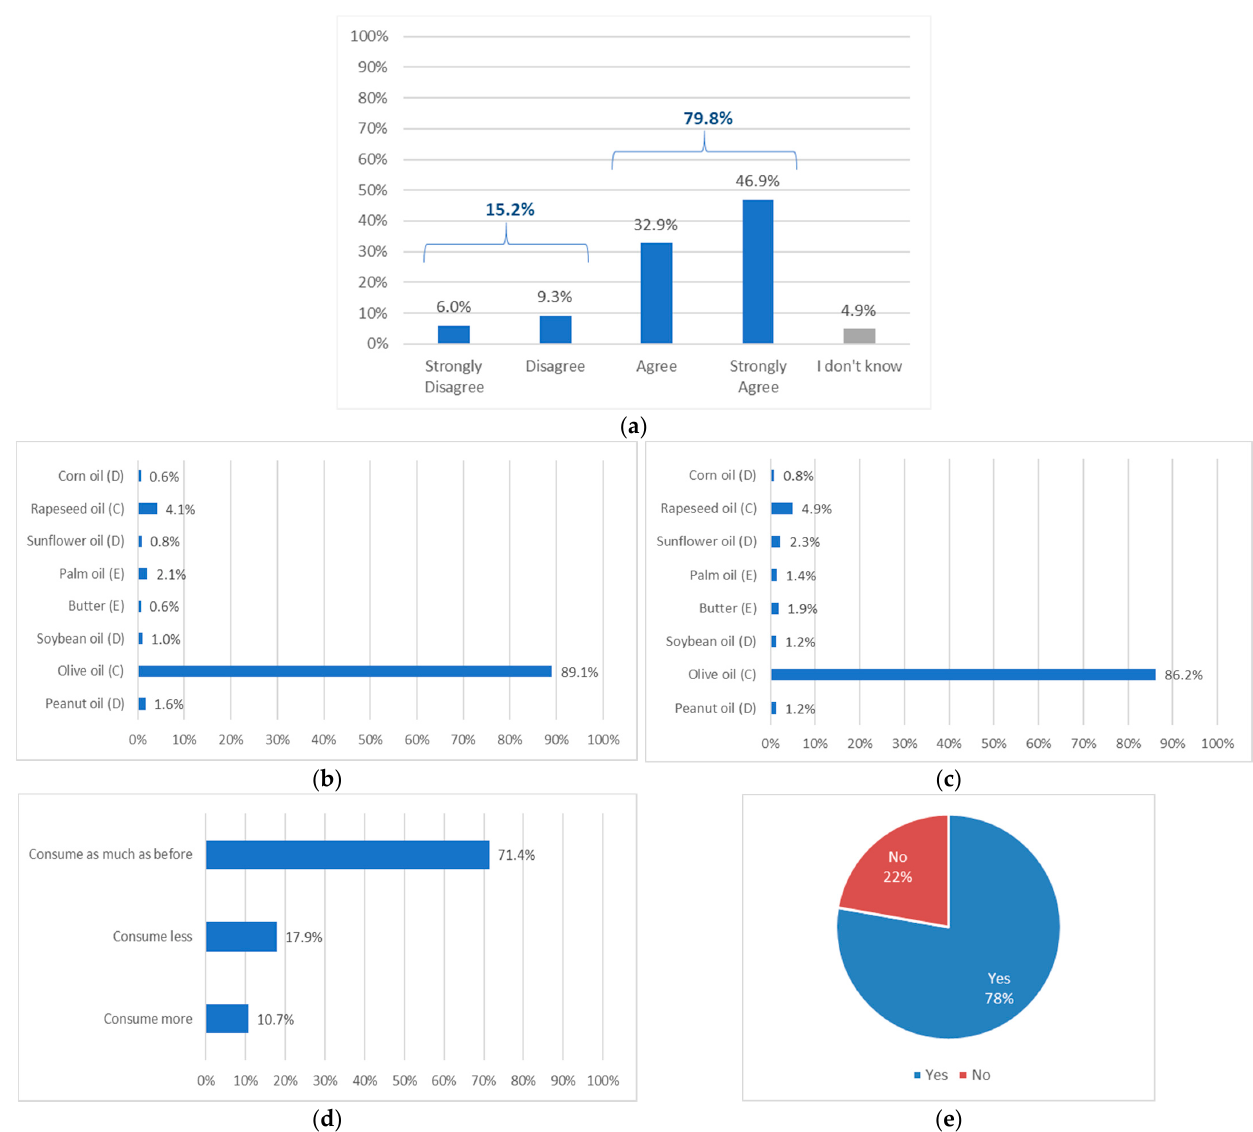
Figure 2. ( a ) Participants’ opinions on the statement “Nutri-Score helps me differentiate the nutritional qualities of the added fats presented”; ( b ) Participants’ answers when selecting the added fat considered to have the best nutritional qualities; ( c ) Participants’ answers when selecting the added fat that they would buy the most frequently; ( d ) Participants’ answers regarding the effect of Nutri-Score C-rated-olive oil on their olive oil consumption; ( e ) Participants’ answers to the question “Do you think olive oil should be labelled with Nutri-Score?” .